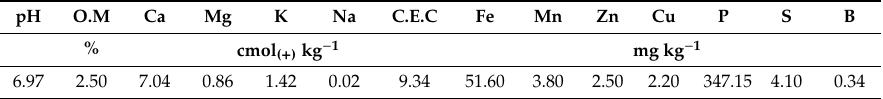
Table 2. Physicochemical soil characteristics used in the plant growth promotion